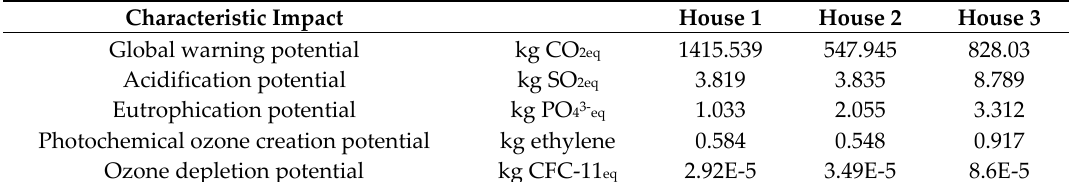
Table 1. Characteristic impacts on 1 m 2 of the total floor area of a family